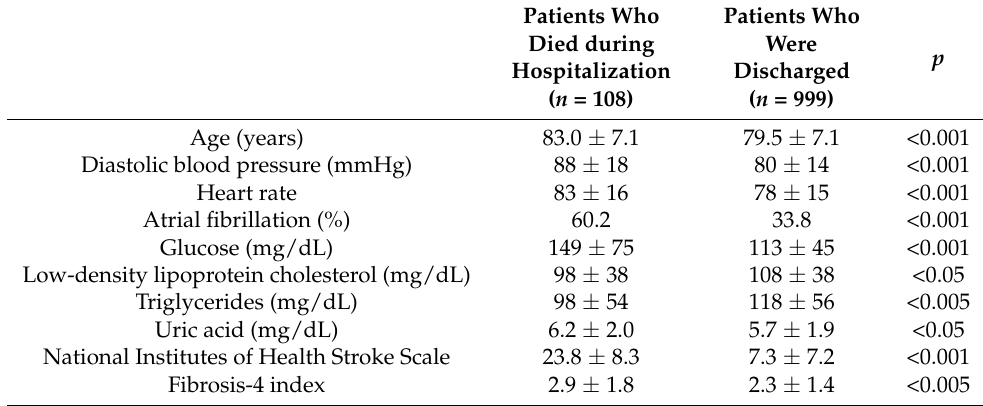
Table 3. Significant differences between patients who died during hospitalization and those who were